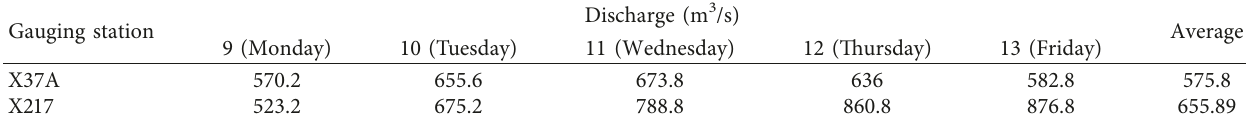
Figure 18: Data elevation model (DEM) for Tapi basin in the south of Thailand. Table 1: Real discharge data on January 9–13,